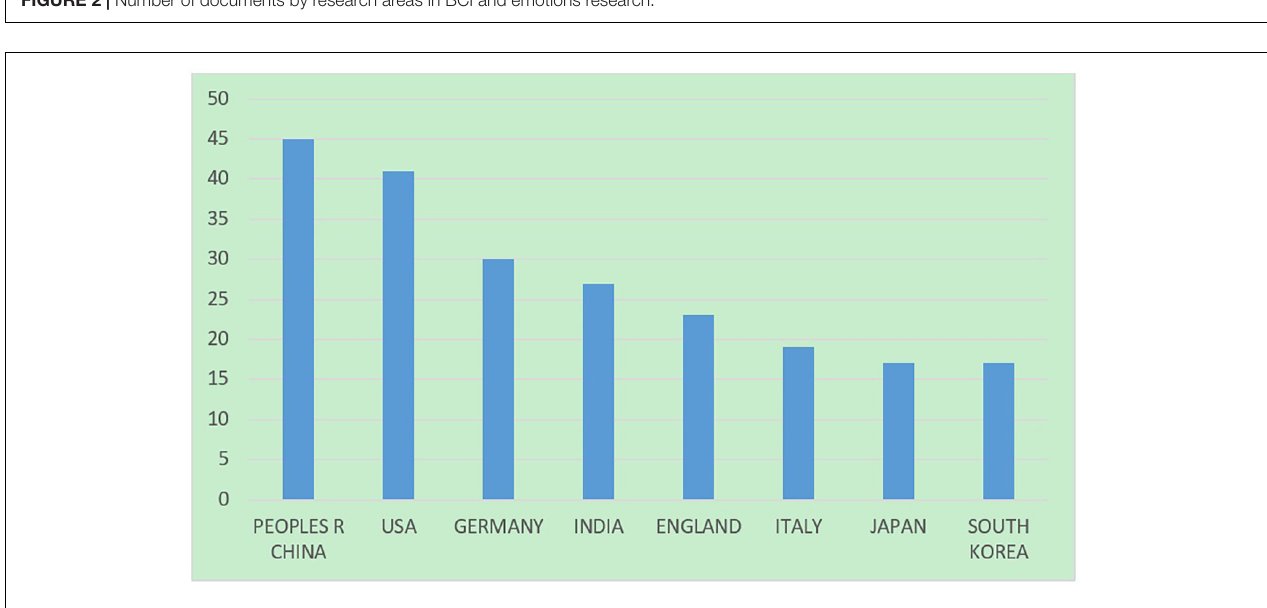
FIGURE 2 | Number of documents by research areas in BCI and emotions research.